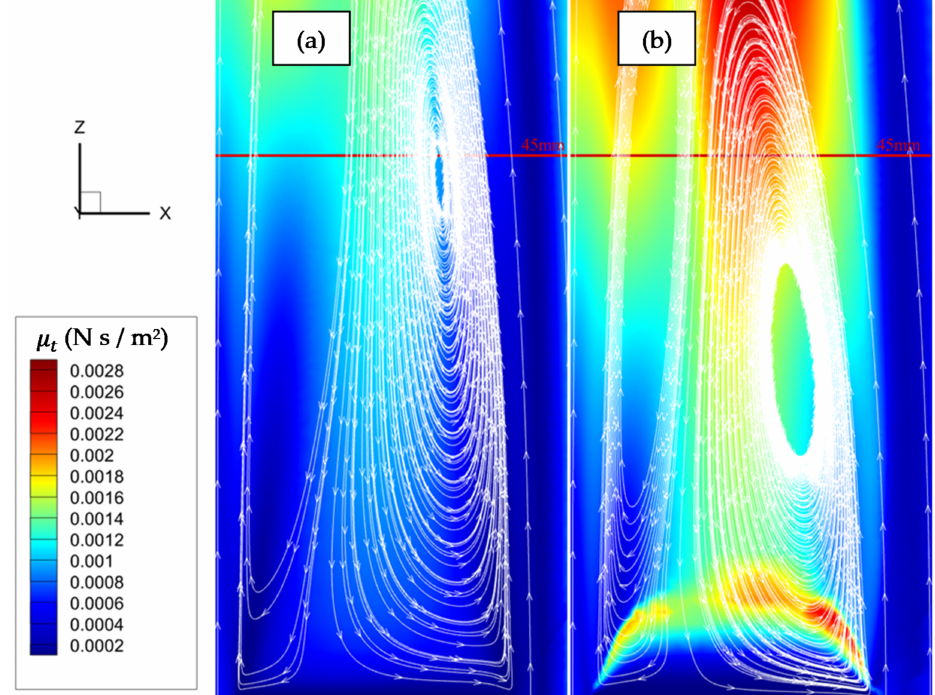
Figure 11. Turbulent viscosity and streamtraces. ( a ) Standard wall function. ( b ) Enhanced wall